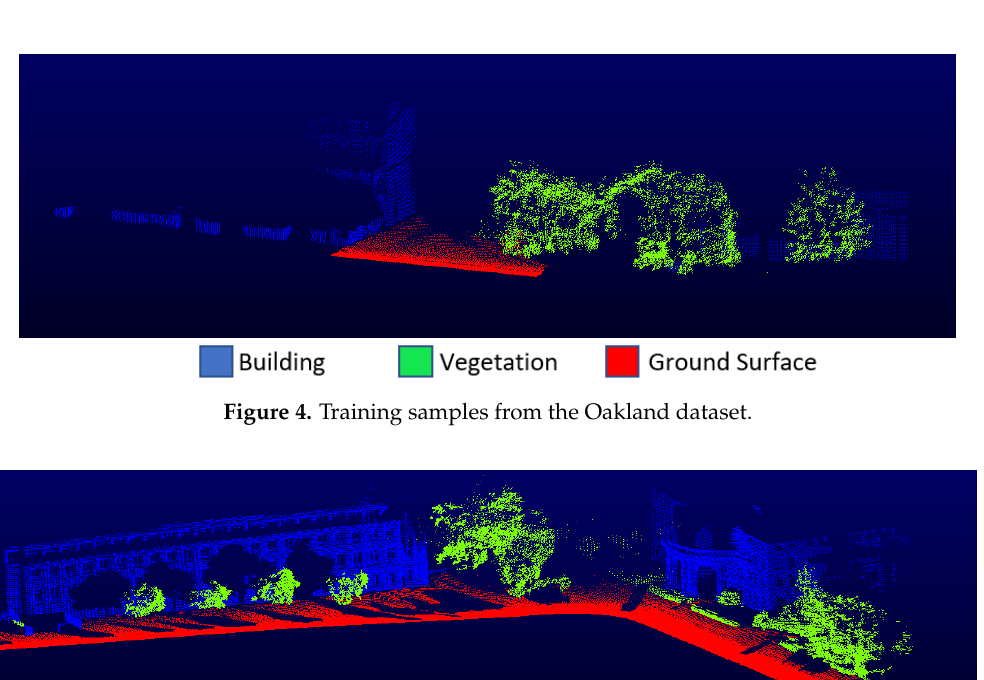
Figure 4. Training samples from the Oakland dataset.